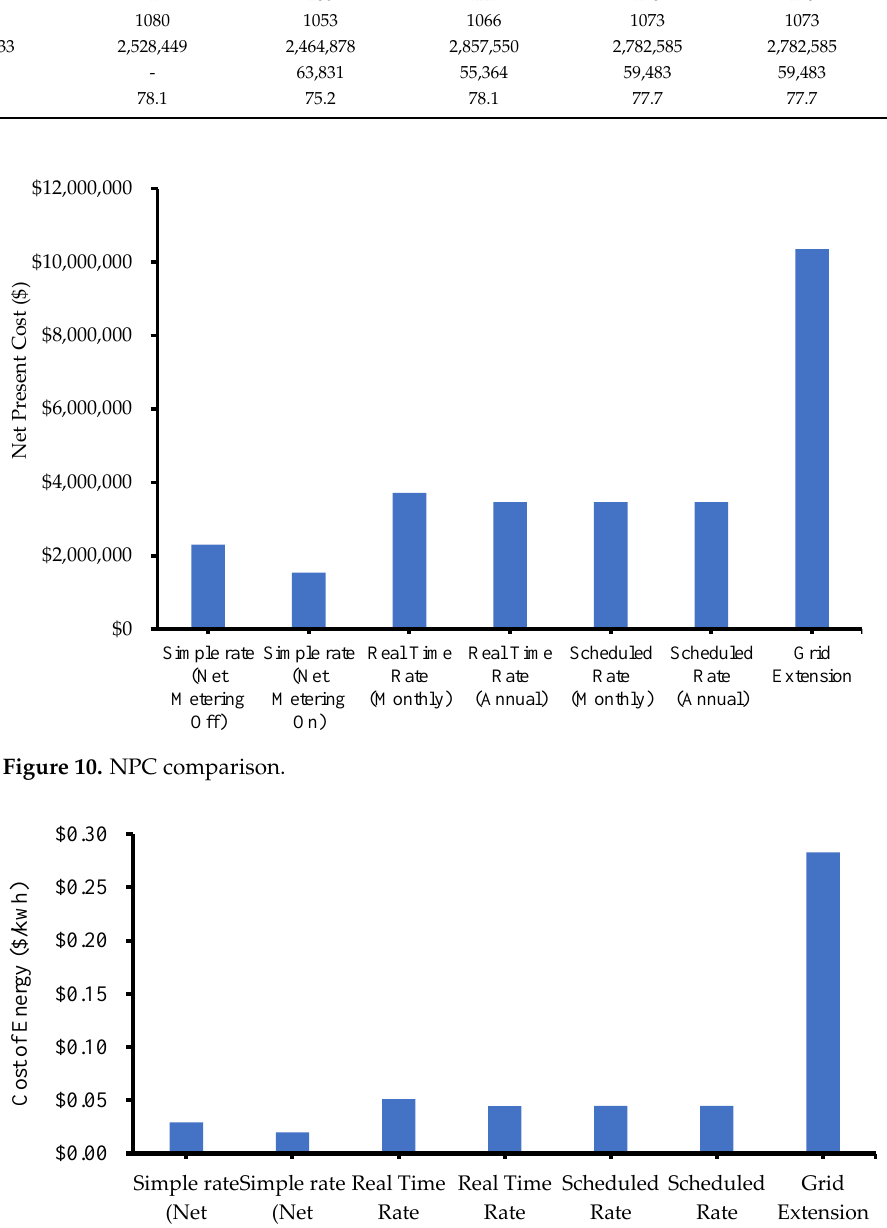
Figure 12. CO 2 emission comparison. 3.2. Case-II: Simple Rate (Net Metering On) The hybrid system configuration based on a PV/Battery/DG was taken into consider- ation. It is evident from Figure 11 that this arrangement has a COE of 0.0198 USD/kWh and an NPC of USD 1,539,620 (Figure 10). It consists of a 1080 kW inverter, four batteries, a 1723 kW PV module, and a 340 kW DG (Table 8). Figure 12 ’ s findings show that of the seven scenarios, the one with the second lowest CO 2 emissions (351,020 kg/y) is the me- tering on. In total, 2,528,449 kWh of power was produced overall in this hypothetical sit- uation. In addition, 79.5% of the total power is supported by the PV, and the residual 20.5% is obtained from grid purchases. Additionally, it is evident from the results that this technique is employed to generate 2.85% of the total amount of energy produced in excess. DGs are not used to generate electricity.